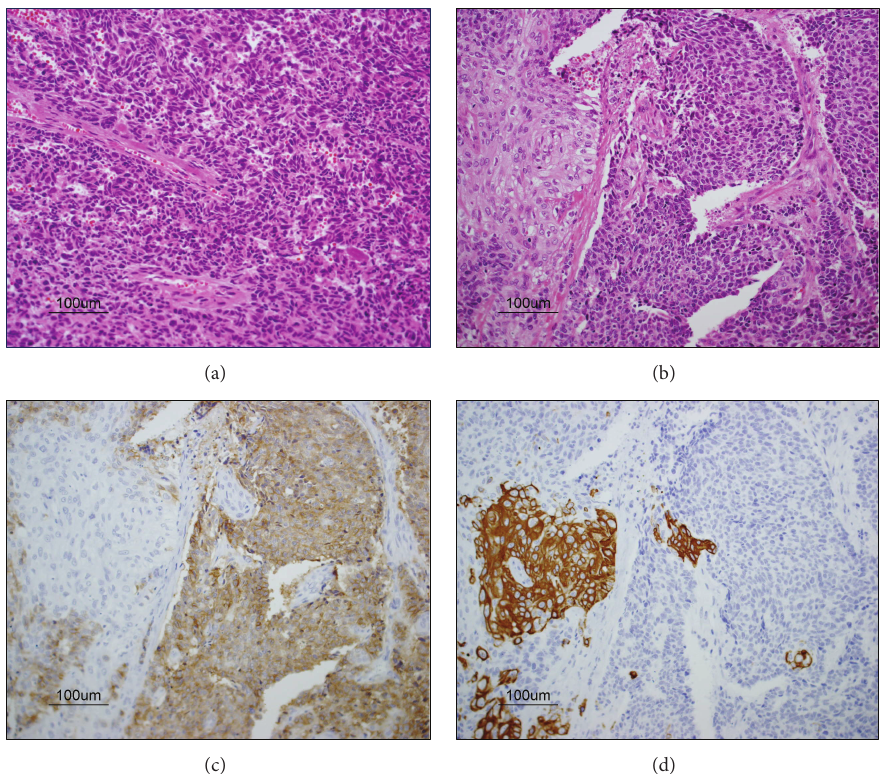
Figure 3: Histopathological examination showsthat thetumor comprises a main small cell carcinoma component (a) and a smaller squamous cell carcinoma component (b). Immunohistochemically, tumor cells of the small cell carcinoma component show positive staining for CD56 (c) but negative staining for CK5/6 (d). By contrast, cells of squamous cell carcinoma component were positive for CK5/6 (d) but negative for CD56